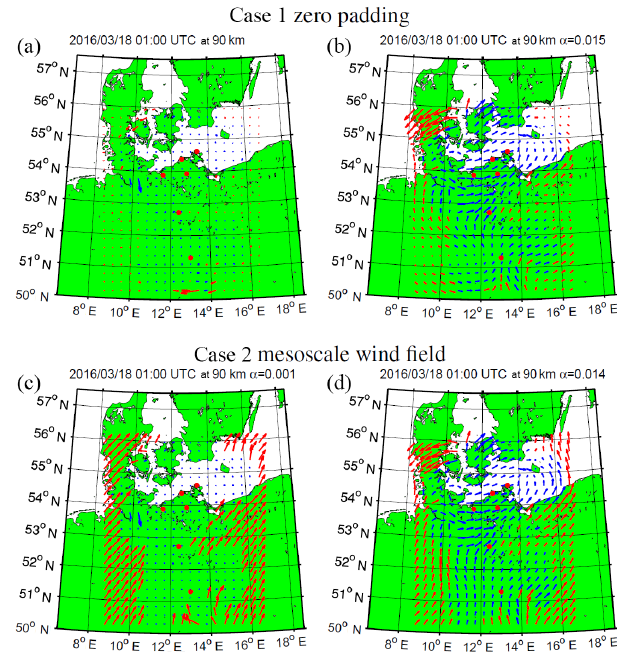
Figure 6. Comparison of wind field solution in dependence of the background mesoscale solution. (a, b) Test case with zero padding: first (a) and final iteration (b) . (c, d) Test case with mesoscale wind field (obtained from the data): first (c) and final iteration (d)